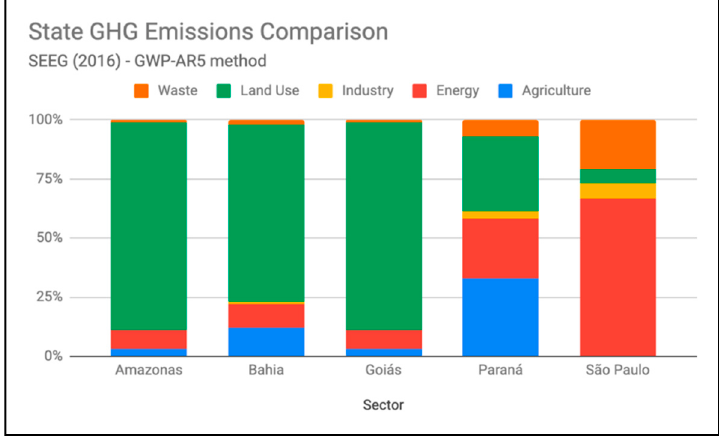
Figure 3. State-level GHG emissions [45].